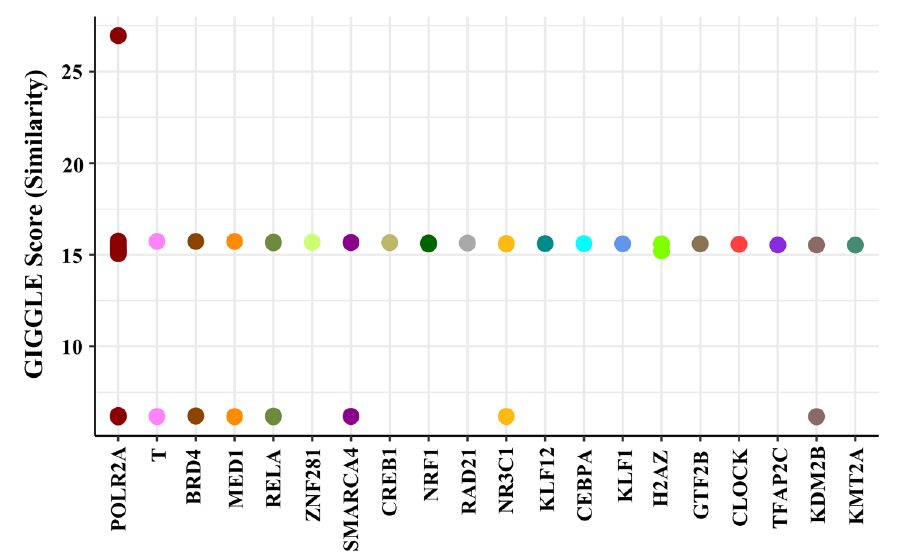
Figure 5. Identification of transcription factors of super-enhancers upregulated genes.